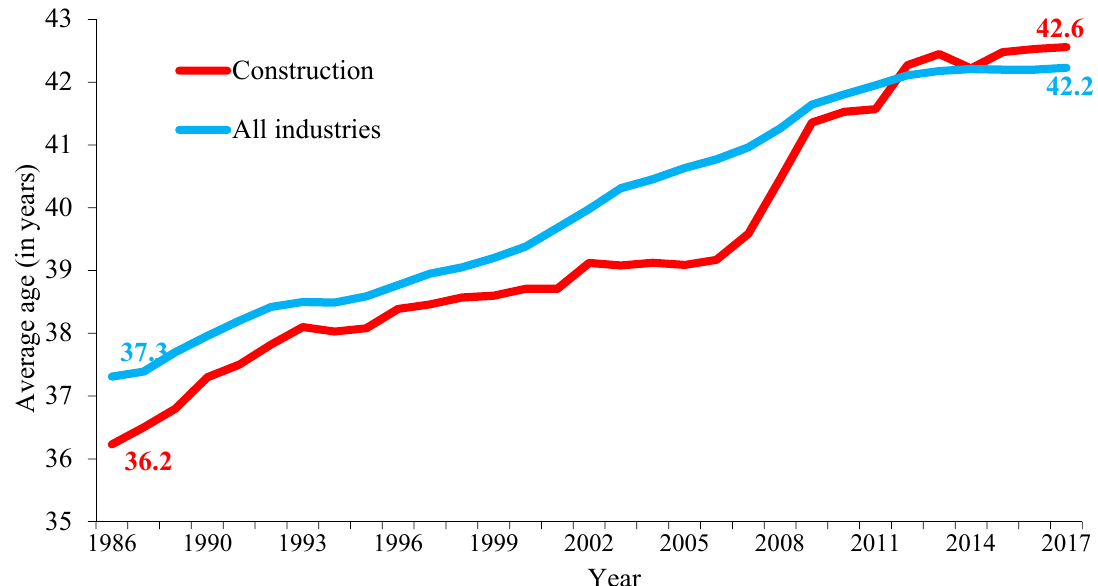
Figure 1. Average age of workers, construction versus all industry (all employment).